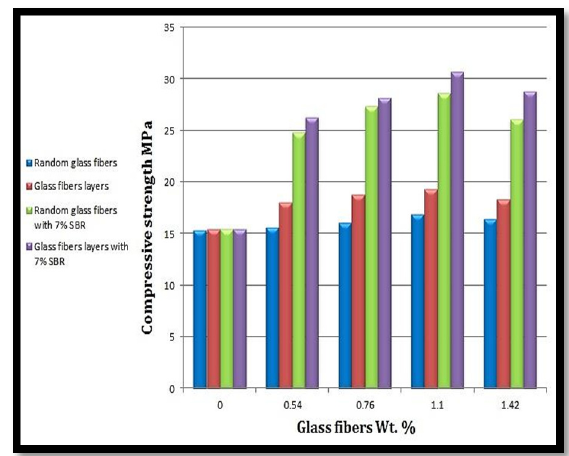
Fig. 12. Comparison between the effect of random and layers glass fibers with and without SBR on compressive strength of mortar after 7 days of curing.